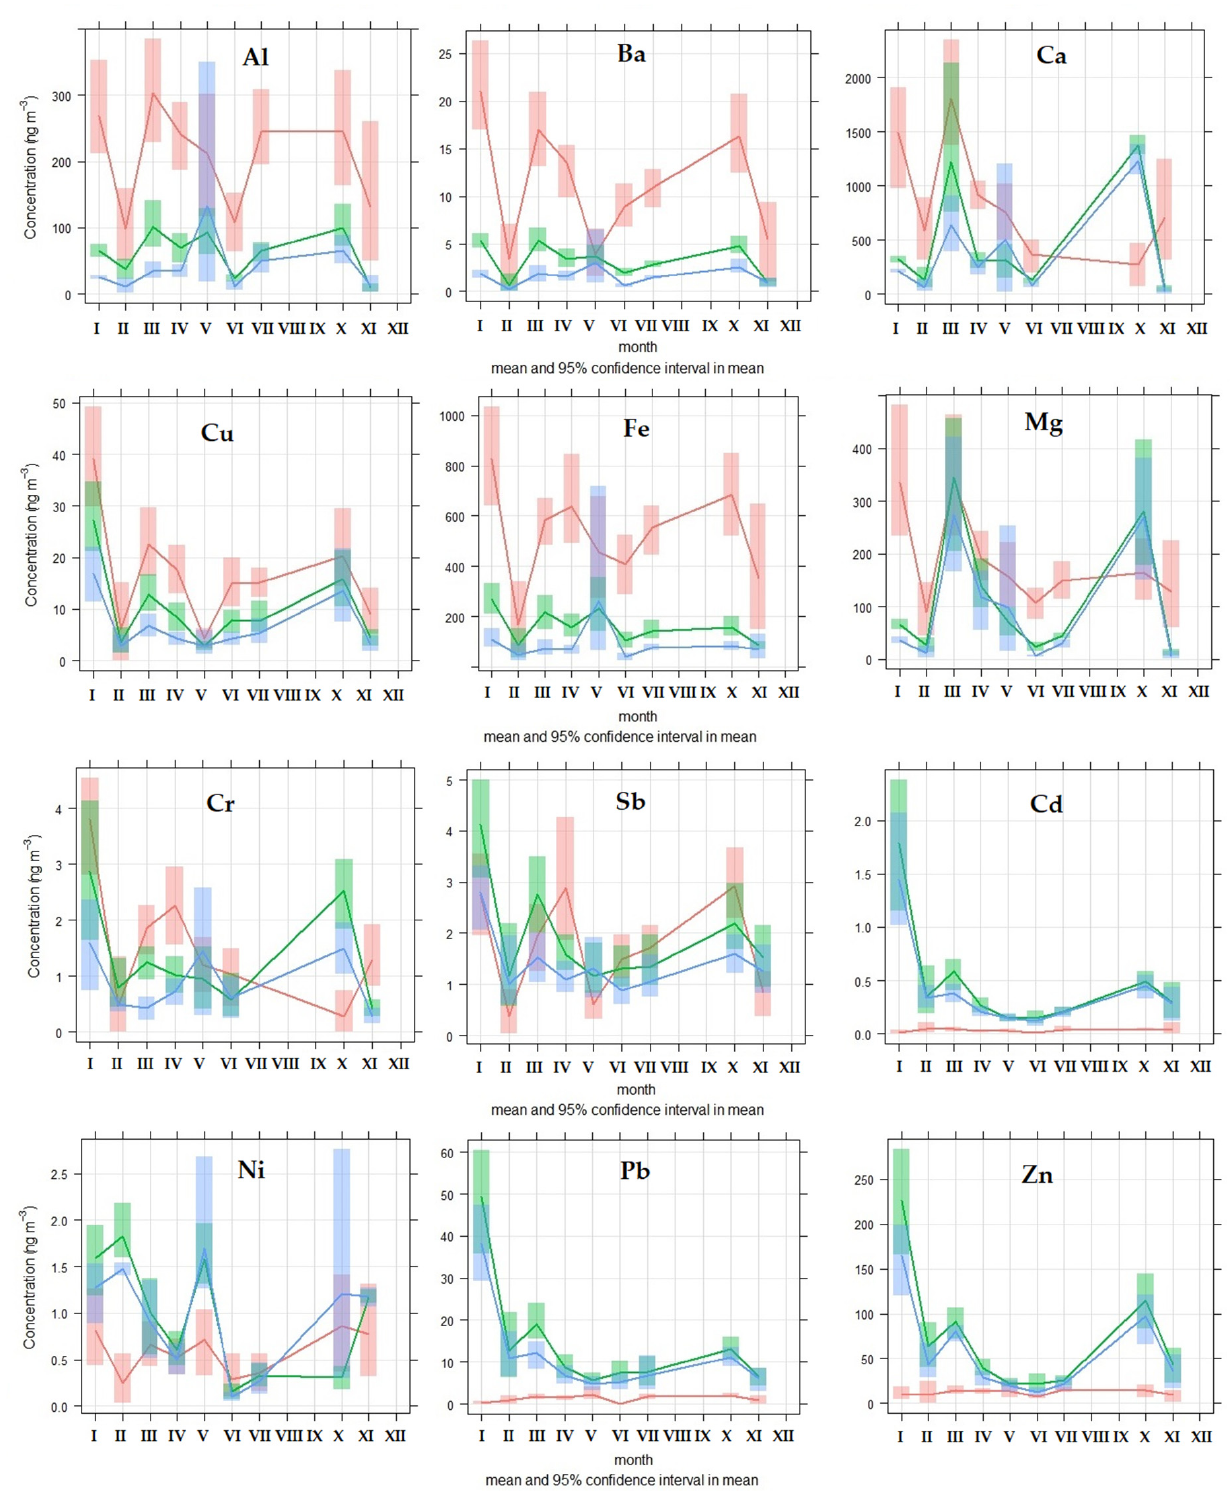
Figure 3. Seasonal variation of concentrations of elements in PM fractions, evaluated based on measurements taken in the city of Žilina (Note—PM 2.5–10 : red; PM 2.5 : green; PM 1 : blue). Furthermore, correlation analysis was used, where the relationship between individual elements was identified (Figures 4–6).